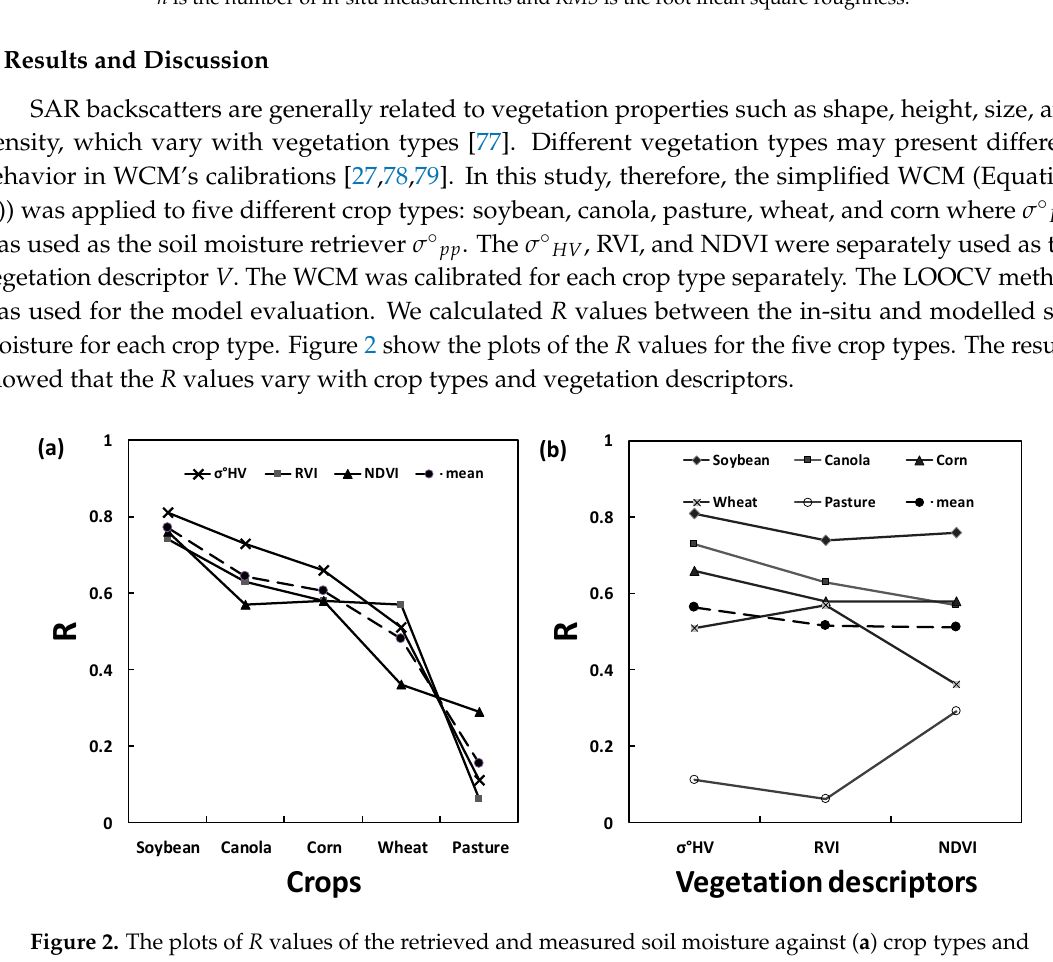
Figure 2. The plots of R values of the retrieved and measured soil moisture against ( a ) crop types and ( b ) vegetation descriptors.